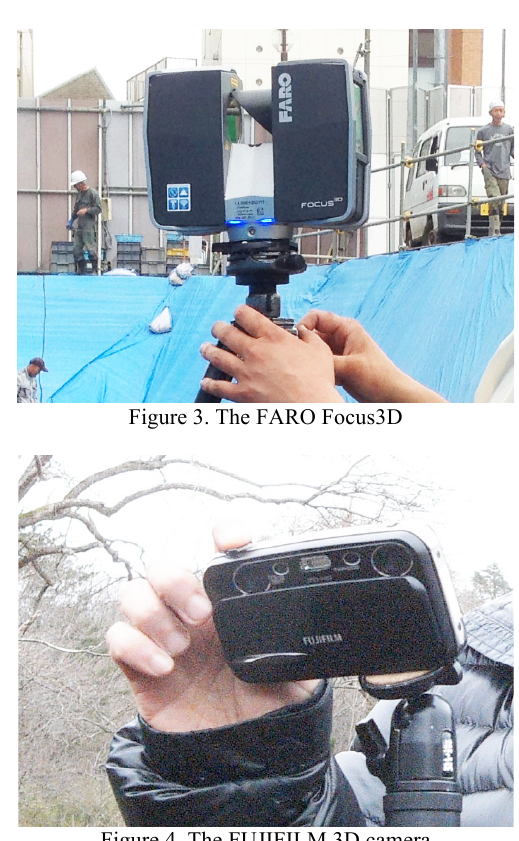
Figure 4. The FUJIFILM 3D